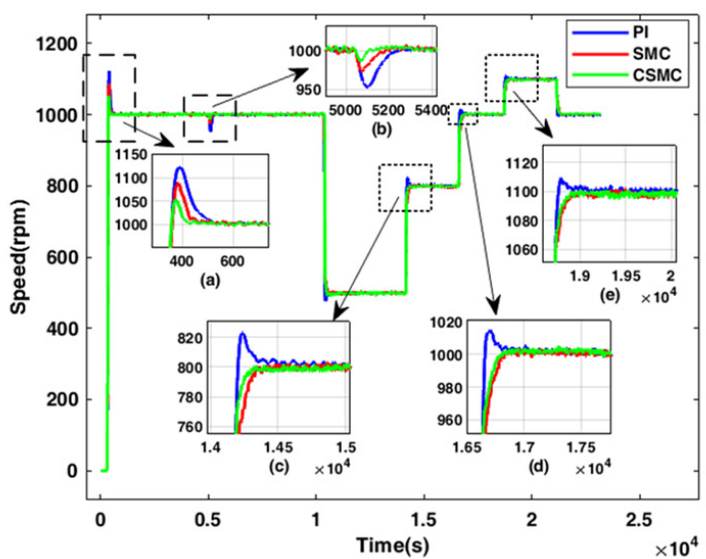
Figure 15. Actual performance response under speed step with 0.112 N · m torque: ( a ) starting performance, ( b ) disturbance rejection ability, ( c – e ) starting performance at different step speeds.